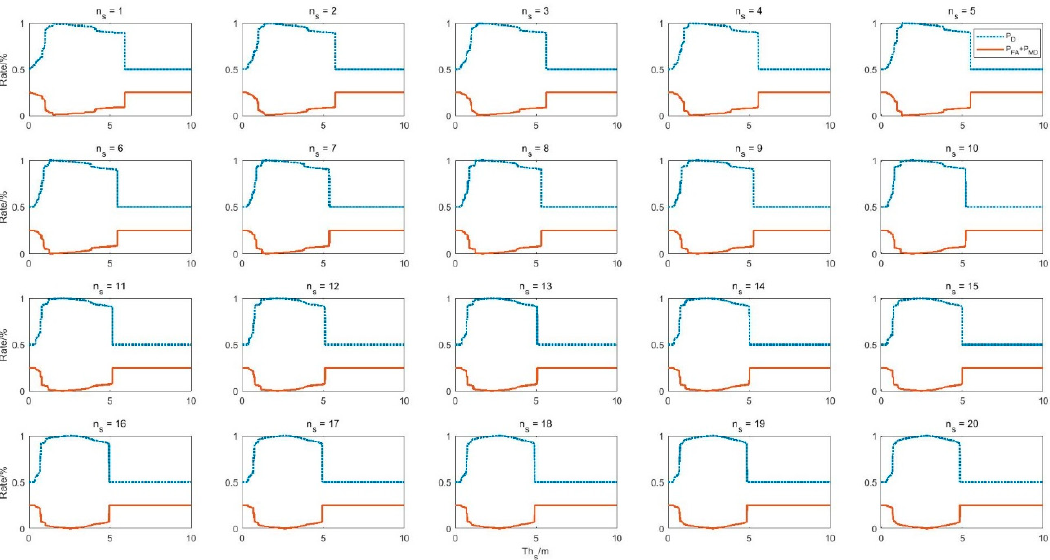
Figure 10. The impact of jump parameter settings: ( a ) the impact of jump verification window; ( b ) the impact of jump =2 n ) . verification threshold ( j